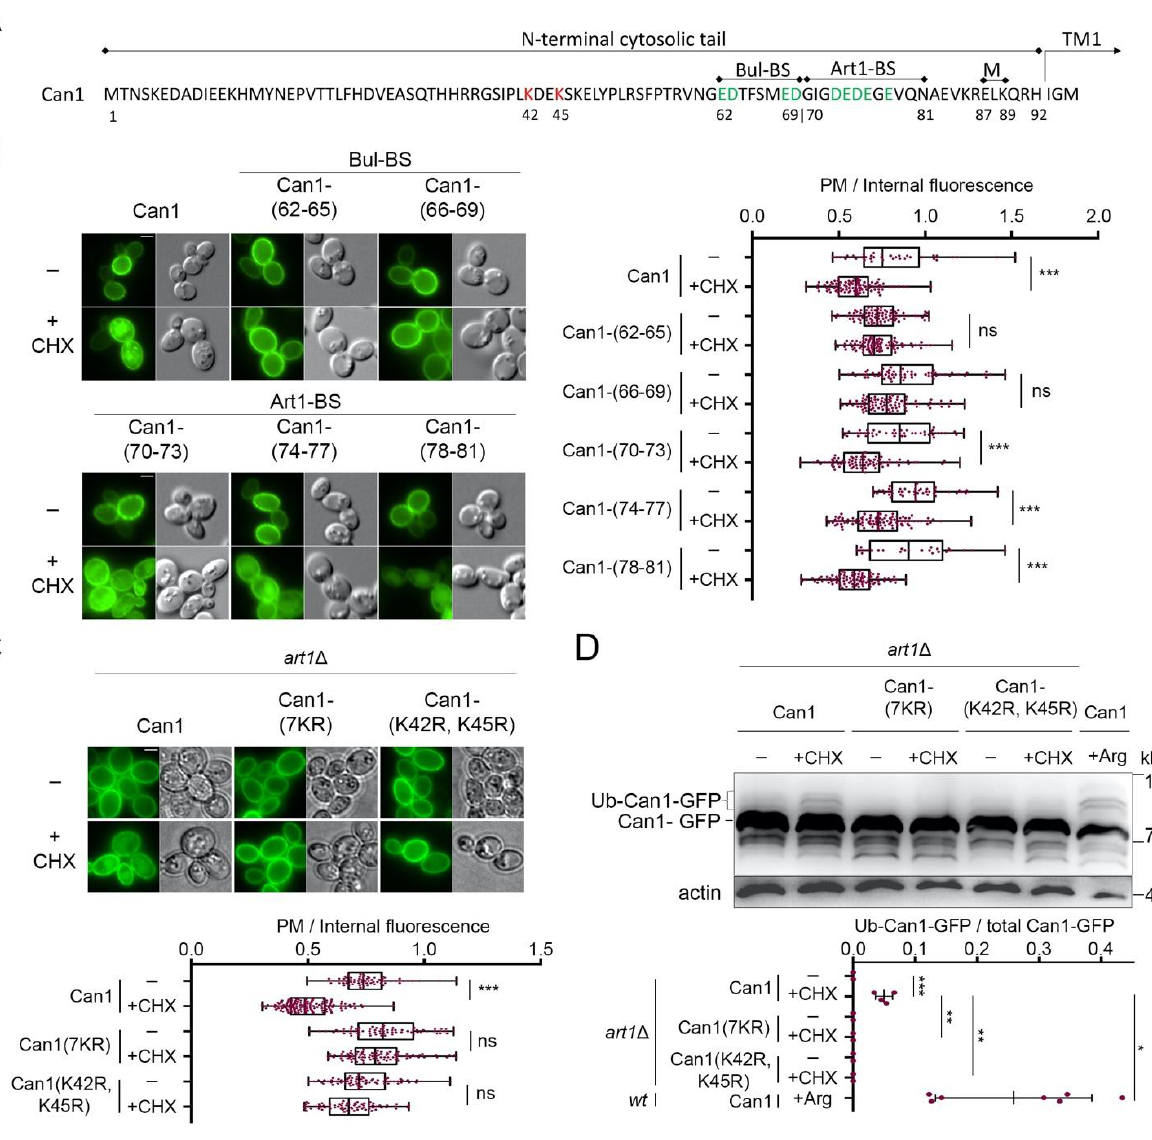
Figure 3. Cycloheximide-induced endocytosis of Can1 requires Lys 42 and Lys 45 residues and an intact putative Bul-BS at the permease N-tail. ( A ) Amino acid sequence of the N-terminus of Can1. The main Ub-acceptor Lys 42 and Lys 45 are highlighted. Residues 62 – 69 and 70 –81 have been identified as the putative binding sites of the Bul1/2 and Art1 α -arrestins, respectively. These sequences are enriched in negatively charged amino acids (highlighted in green). Residues 87 – 89, previously shown to be important for masking the Art1-BS in the outward-facing conformation [29], are also highlighted. ( B ) Epifluorescence microscopy of strains expressing wt Can1-GFP or Can1-GFP mutants carrying Ala-substitutions at the indicated residues of the N-tail. These residues of Can1 comprise the probable binding sites for Art1 (Art1-BS) or Bul1/2 (Bul-BS). Strains were grown on Gal, Am MM, Glu was added for 60 min and then CHX for 3 h before imaging, as in Figure 2A. Quantifications: Plasma membrane (PM) to internal GFP fluorescence intensity ratios are plotted ( n = 25 – 101 cells). Quantifications, representations and scale bar as in Figure 2A. ( C ) Epifluorescence microscopy of art1 Δ cells expressing Can1-GFP or the indicated Lys-to-Arg substitution alleles. Glu was added for 90 min and then CHX for 3 h before imaging, as in Figure 2A. Quantifications: Plasma membrane (PM) to internal GFP fluorescence intensity ratios are plotted ( n = 70 – 135 cells). Quantifications, representations and scale bar as in Figure 2A. ( D ) art1 Δ cells expressing the indicated Can1-GFP alleles were grown on Gal, Am MM. Glu was added for 30 min, a non-treated sample was collected (-) and then CHX or Arg was added for 30 or 20 min, respectively. Total protein extracts were probed and analysed as in Figure 2B. Lower exposure is provided in supporting information. The low mobility bands correspond to Ub-Can1-GFP conjugates. Quantifications: The ratio of Ub-Can1-GFP/Total Can1-GFP are plotted in scattered plots. Red dots represent the individual biological replicates. ***, p < 0.001; **, 0.001< p < 0.01; *0.01< p < 0.05; ns, nonsignificant, p > 0.05.